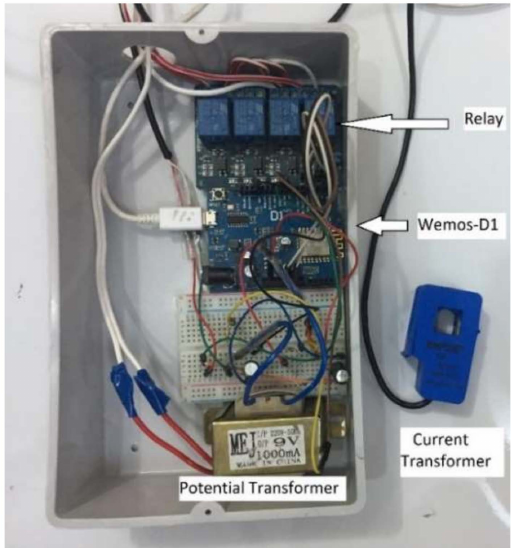
Figure 10. Terminal